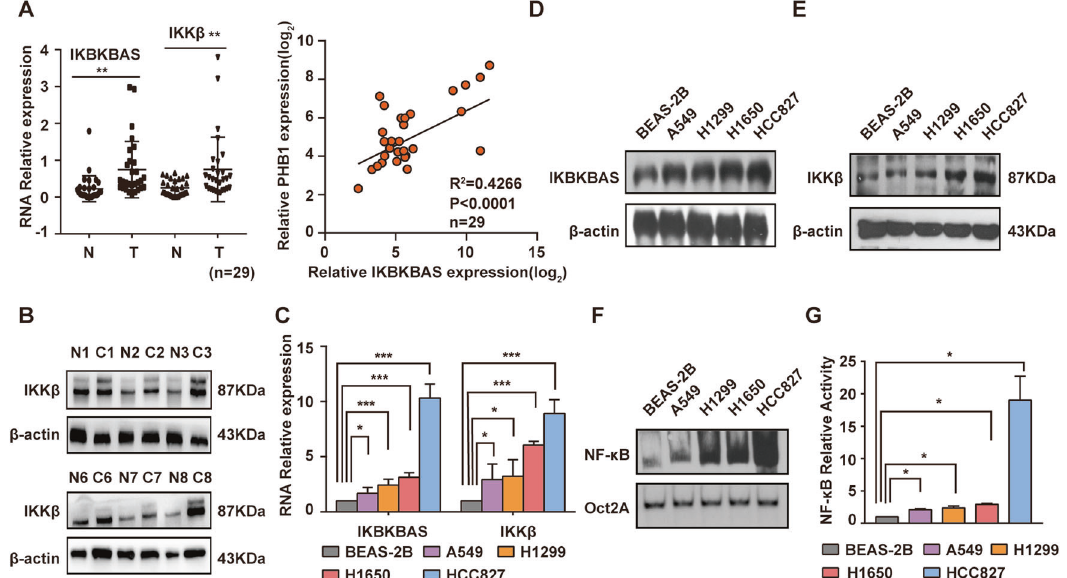
Fig. 1 IKBKBAS is upregulated both in LUAD tissues and cells along with the upregulation of IKK β and activation of NF- κ B. A Validation and correlation of the IKBKBAS and IKK β expression in LUAD specimens compared to their adjacent normal tissues by qRT-PCR analysis. B Partial results of western blotting on IKK β expression in LUAD tissues compared to their adjacent normal tissues. C Basal expression of IKBKBAS and IKK β in LUAD cell lines A549, H1299, H1650, HCC827, and normal cell lines BEAS-2B examined by qRT-PCR analysis. D Basal expression of IKBKBAS in LUAD cell lines A549, H1299, H1650, HCC827, and normal cell lineBEAS-2B examined by northern blotting. E Basal expression of IKK β in LUAD cell lines A549, H1299, H1650, HCC827, and normal cell line BEAS-2B examined by western blotting. F Basal NF- κ B activity in LUAD cell lines A549, H1299, H1650, HCC827, and normal cell line BEAS-2B showed by EMSA. G Luciferase reporter assay performed in LUAD cell lines A549, H1299, H1650, HCC827, and normal cell line BEAS-2B. Data show mean ± S.E.M., n ≥ 3, * P < 0.05, ** P < 0.01, *** P <